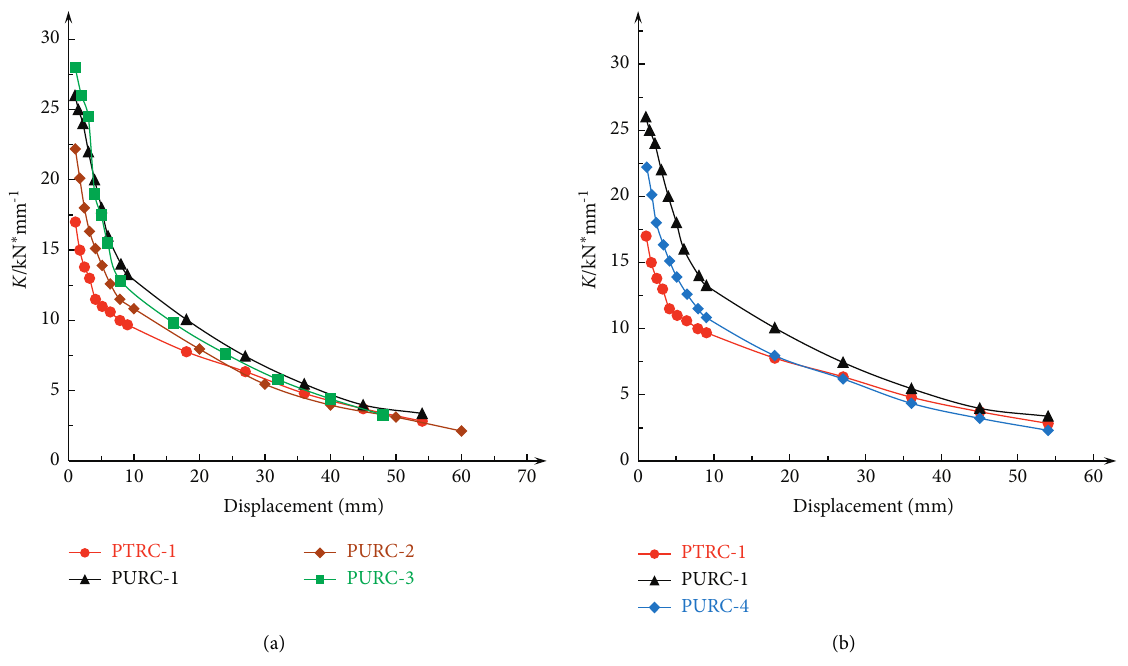
Figure 7: Stiffness degradation curves of